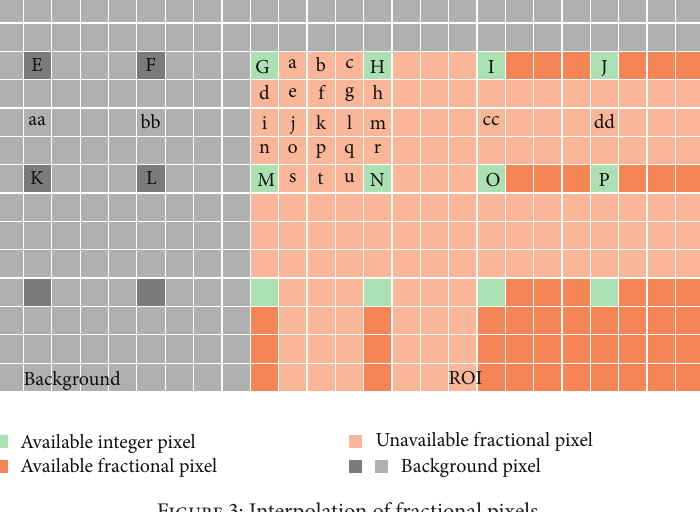
Figure 3: Interpolation of fractional pixels.